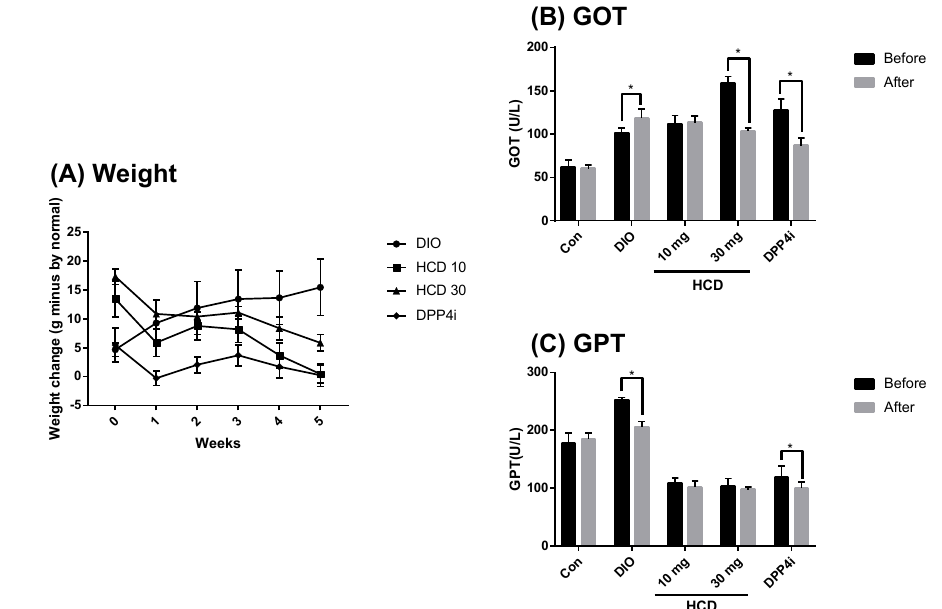
Figure 8. Estimating overall- and hepato-toxicity of selected natural compounds during long-term administration. Overall and hepatotoxicity in DIO mice fed with HCD or sitagliptin (DPP4i) for 5 weeks were monitored by ( A ) Body weight, ( B ) GOT, and ( C ) GPT. All results were mean ± SD from 6 individuals. * p < 0.05 meant significantly different as compared to that before treatment .